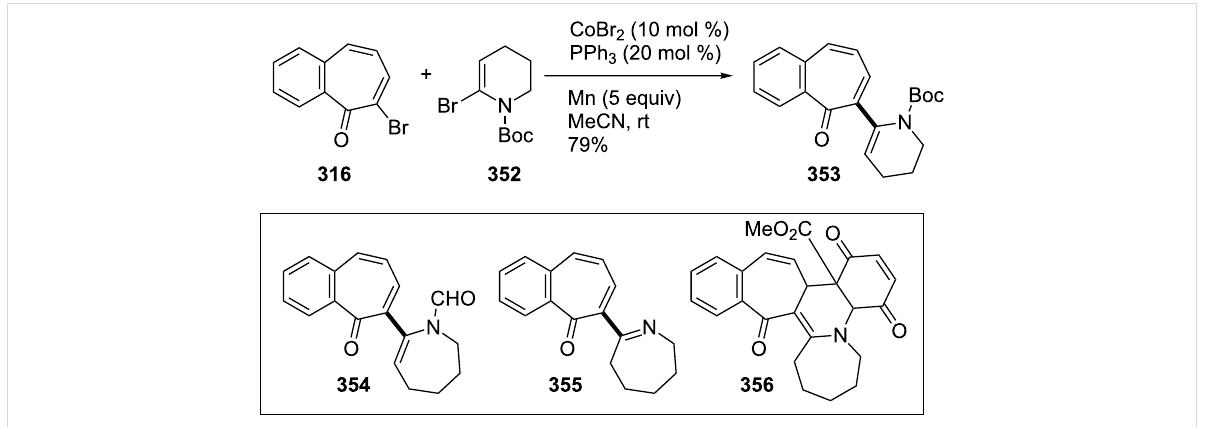
Scheme 63: Cobalt-catalyzed reductive cross-couplings of 7-bromo-2,3-benzotropone ( 316 ) with cyclic α -bromo enamides.